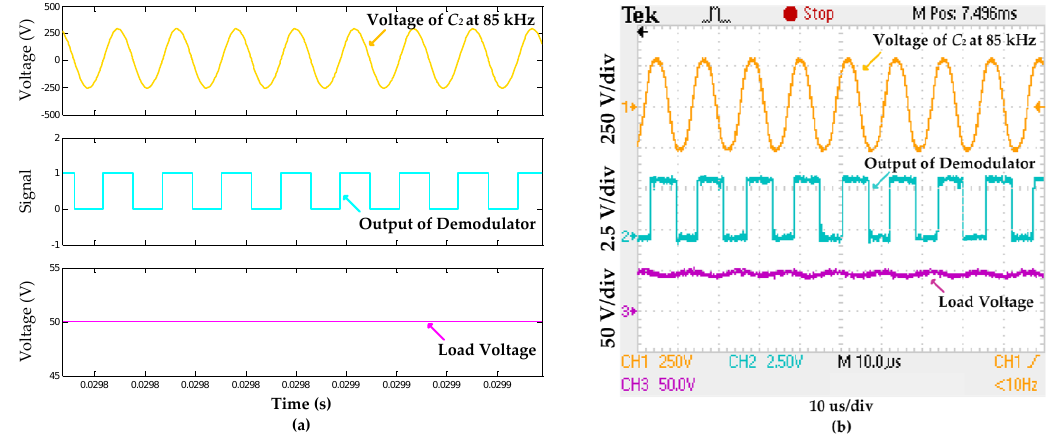
Figure 12. The transmission waveform of power transmission at 85 kHz ( a ) simulation result ( b ) experimental result.